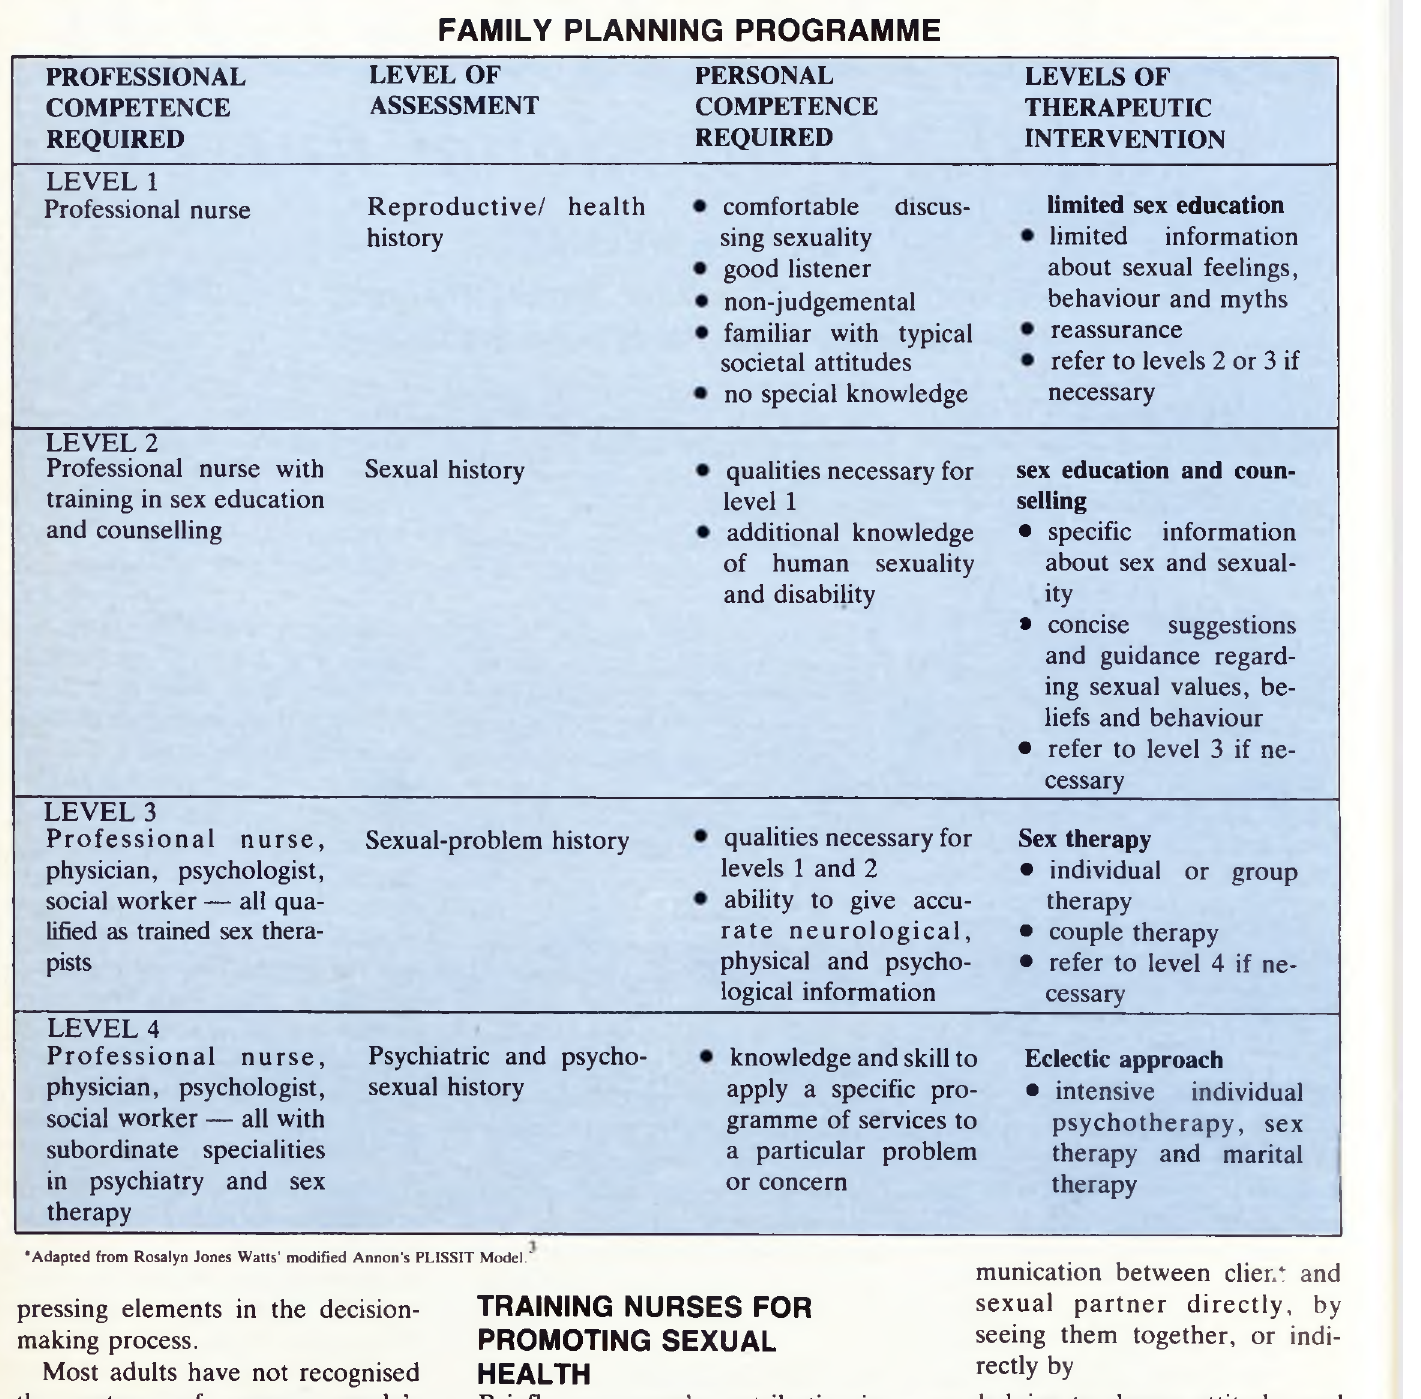
Table 1: LEVELS OF ASSESSMENT AND INTERVENTION IN SEXUAL